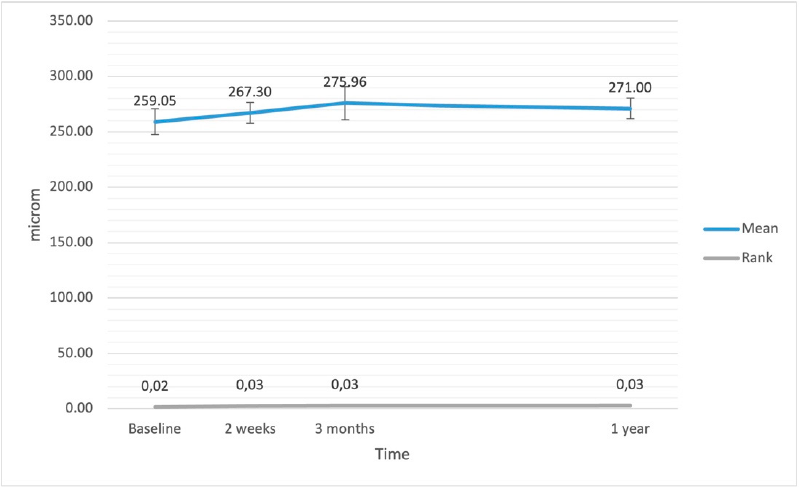
Figure 2. Central retinal thickness (CRT) at baseline and after the surgery. The error bars represent 95% CI of the obtained results.